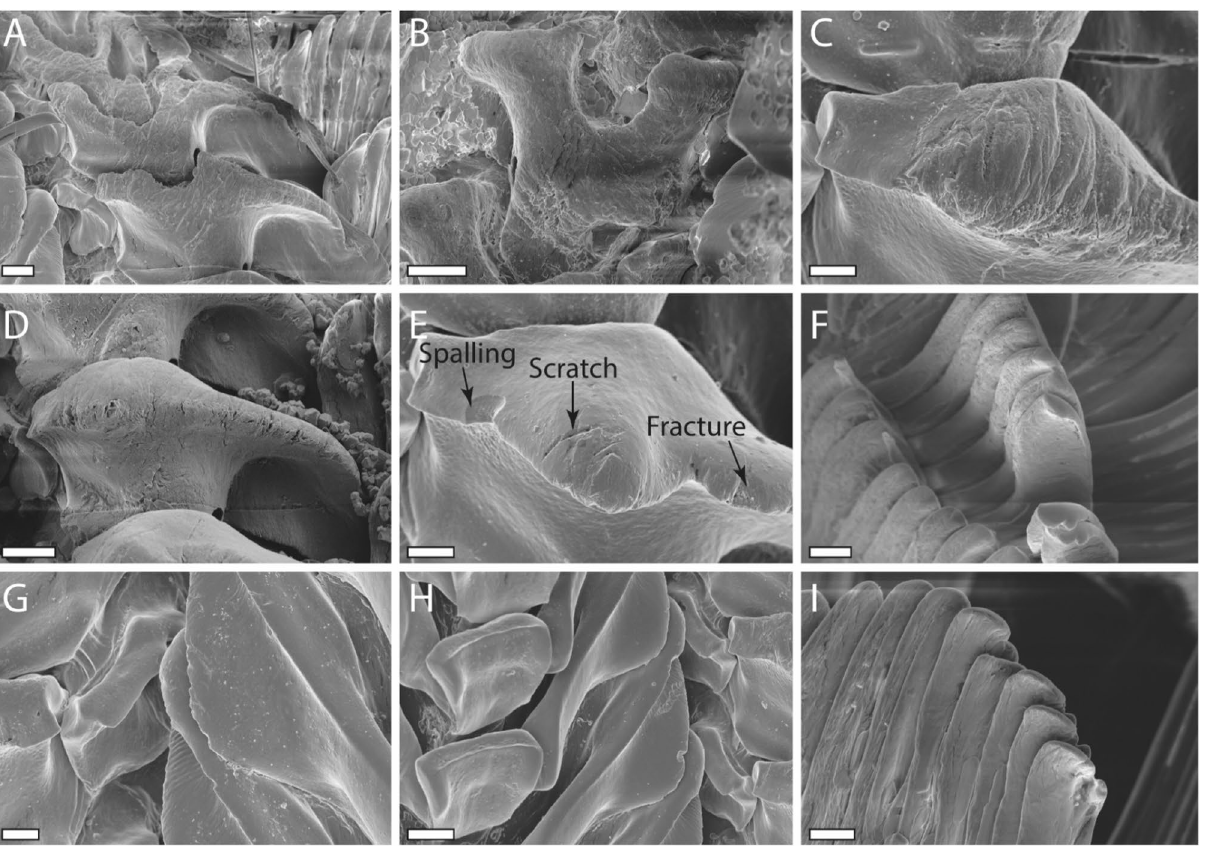
Figure 7. Detailed SEM images of worn radular teeth depicting different kinds of wear (spalling, scratch, fracture). ( A – E ) Lateral tooth II. ( F , I ) Inner marginal teeth. ( G – H ) Lateral tooth I. Scale bars: A, D, E,